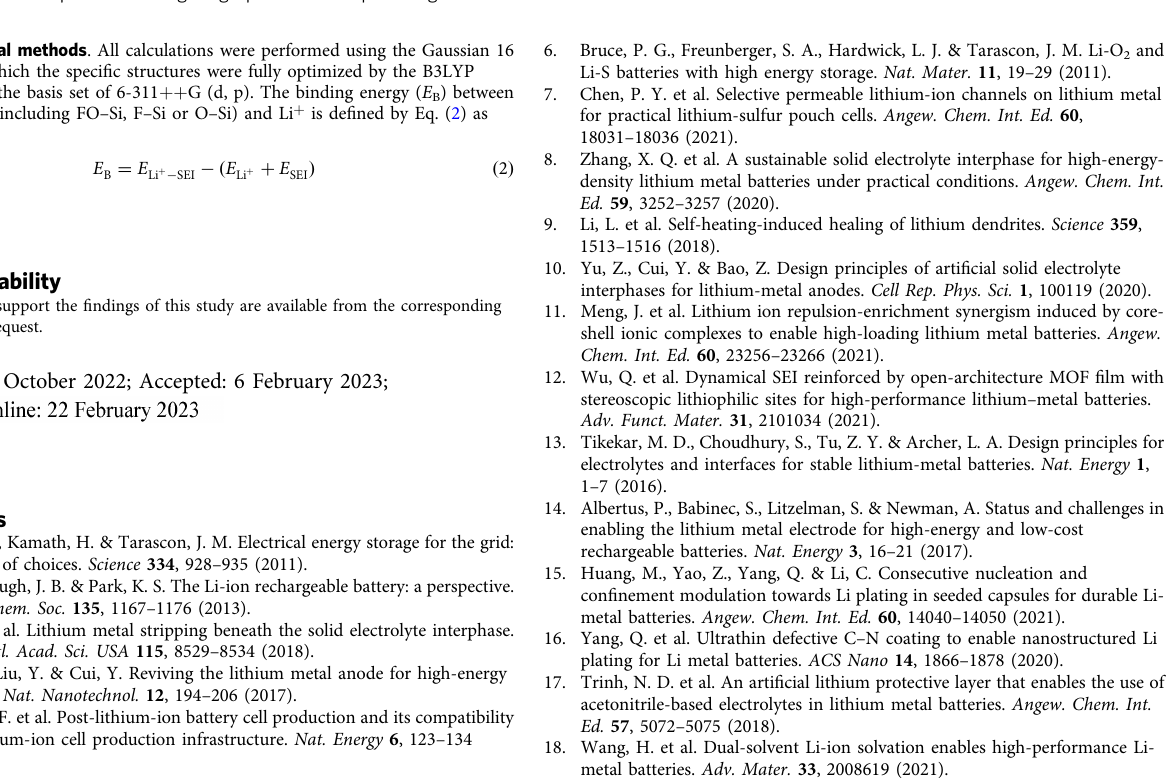
Fig. 7 Electrochemical performance of FO – Si@Li||NCM811 coin and pouch cells with a thin Li foil of 50 μ m. a Cyclic performance and b selected GCD curves of FO – Si@Li||NCM811 coin cell at 1 C. c Cyclic performance and d selected GCD curves of FO – Si@Li||NCM811 pouch cell at 0.5 C. Optical photographs of the pouch cell e lighting up LEDs and f powering two